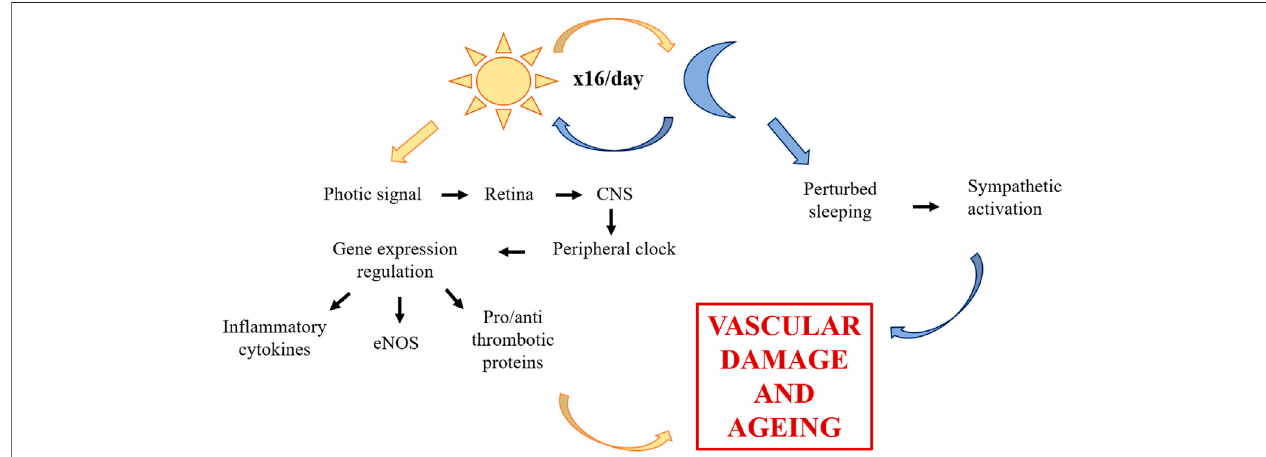
FIGURE 1 | Role of circadian rhythm dysregulation on the vascular system. Through photic signal, circadian rhythm in fl uences CNS, which then coordinates peripheral clocks of vascular cells. The alteration of eNOS, in fl ammatory cytokines and pro- and anti-thrombotic proteins promotes vascular damage and accelerates vascular aging. Furthermore, circadian rhythm dysregulation induces sleep disorders which increase vascular disease risk. CNS, central nervous system; eNOS, endothelial nitric oxide synthase.